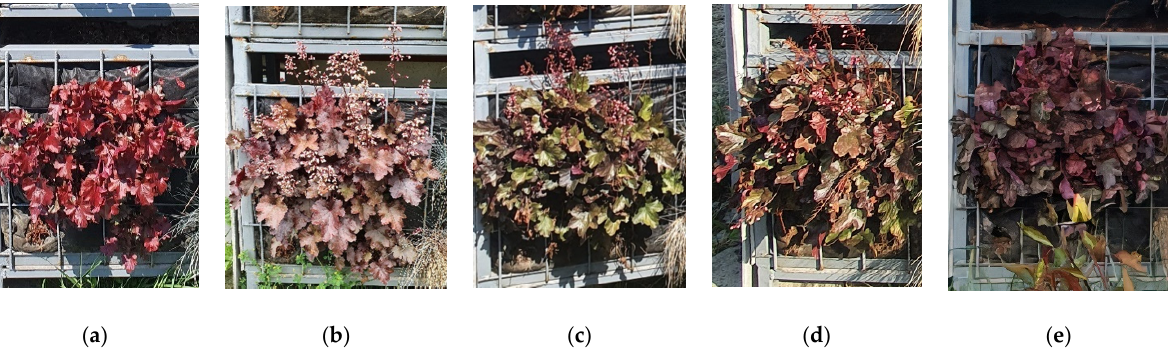
Figure 16. Heuchera x hybrida ‘Fire Alarm’ May – December 2020, level 1, southern facade: ( a ) May; ( b ) June; ( c ) August; ( d ) September; and ( e ) December. As for the height and diameter of the plant, in the growing season (May and August) on the southern and western facades, the highest average values were recorded. During the rest period, on these facades, the mentioned parameters recorded the lowest average values but were closest to the values obtained on the other cardinal orientations (Figure 17).